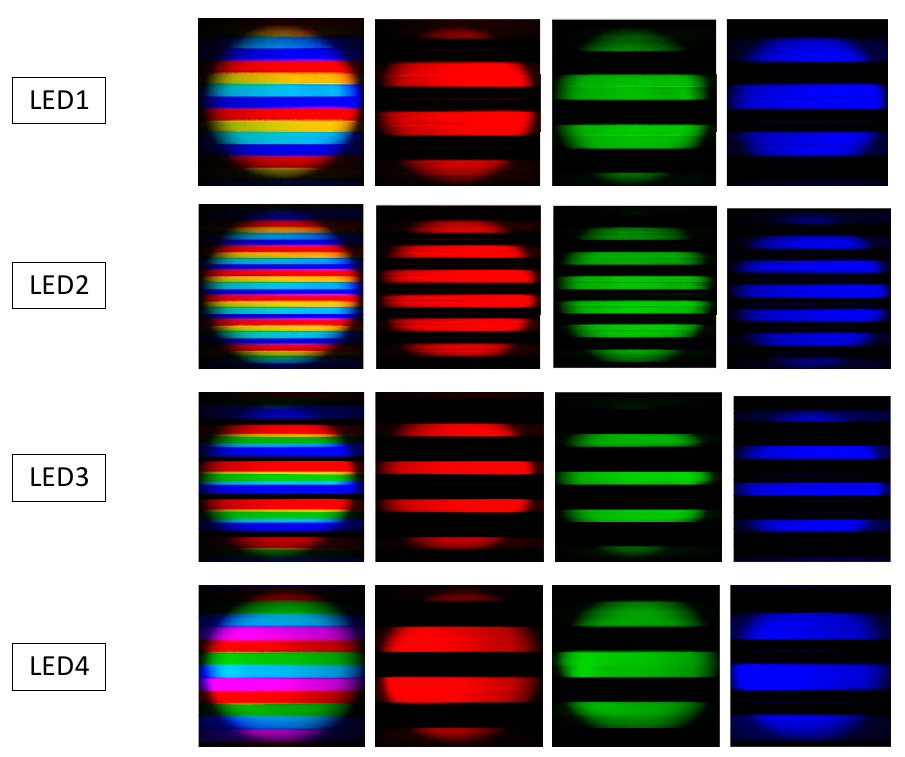
Figure 4. Different LED images captured using a CMOS sensor (1).